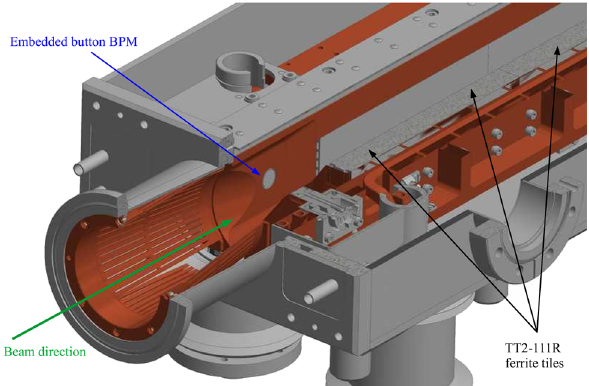
FIG. 3. LHC Run II TCS/TCT collimator with embedded BPM pickup